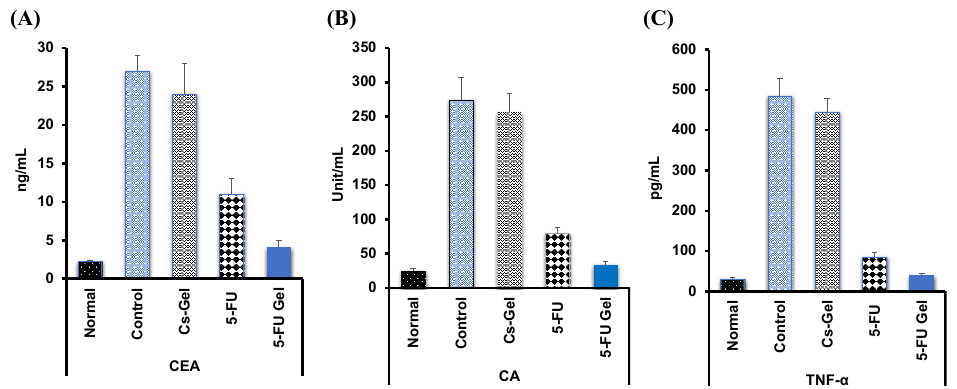
Figure 8. Effect of injected 5-FU hydrogel systems on breast tumor markers (CEA ( A ), CA ( B ), TNF- alpha ( C )) which were determined in the blood of the investigated groups of rats. The data were presented as the mean ± SD ( n = 3).